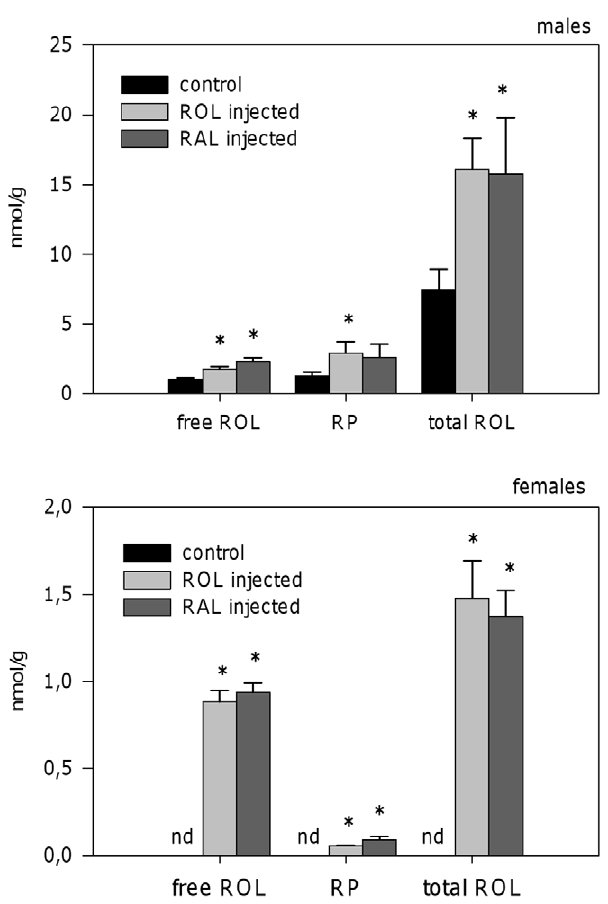
Figure 5. Nonpolar retinoids in Osilinuslineatus after intramus- cular injections with retinol or retinaldehyde . Free retinol, retinyl palmitate and total (free + esterified) retinol levels in digestive gland- gonad complex of O. lineatus 48 hours after injection with DMSO (control), retinol (4 m g/g body mass) or retinal (4 m g/g body mass). Values represent mean 6 SEM (n=5–7). Asterisks indicate significant differences from respective control group (P , 0.05, in males: one-way ANOVA followed by the Tukey post-hoc test; in females: one-sample t - test).